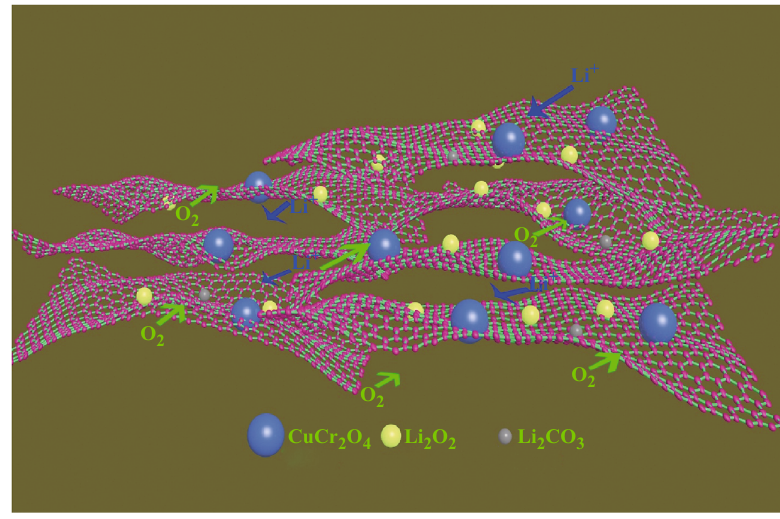
Fig. 6 Schematic illustration for the function of LOBs using CCO@rGO